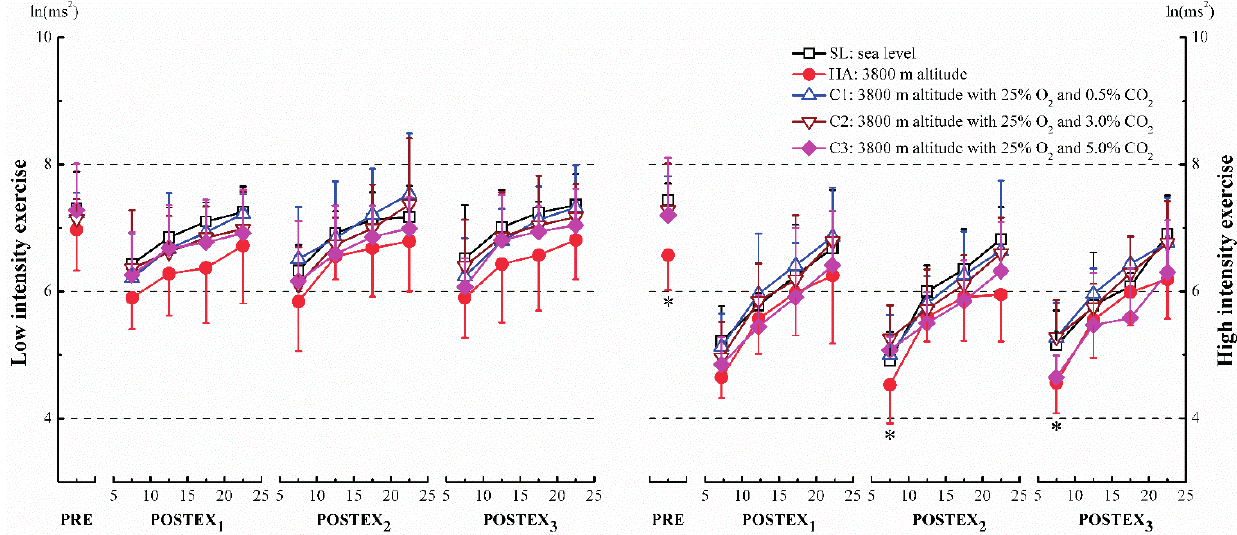
Figure 3. Low frequency (LF) in pre-exercise (PRE) and post-exercise (POSTEX 1 , POSTEX 2 and POSTEX 3 ). * p < 0.05, compared with SL in the same segment